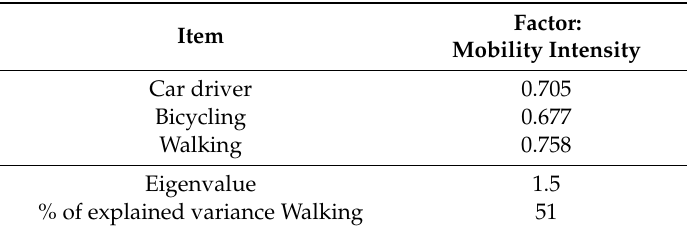
Table 1. Principal component analysis mobility